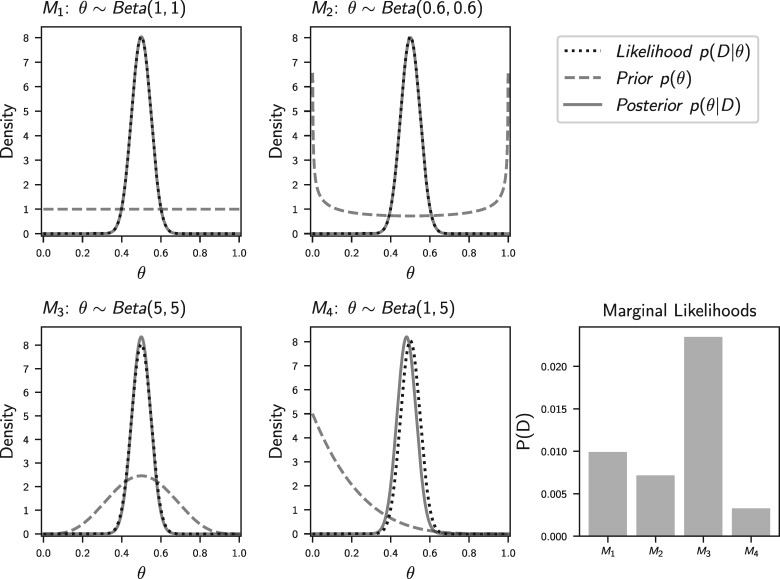
An illustration of the posterior probability densities and marginal likelihoods of the four different prior assumptions we made in our coin-flipping experiment. The data are 50 “heads” out of 100 coin flips, and the parameter, \documentclass[12pt]{minimal}
\usepackage{amsmath}
\usepackage{wasysym}
\usepackage{amsfonts}
\usepackage{amssymb}
\usepackage{amsbsy}
\usepackage{upgreek}
\usepackage{mathrsfs}
\setlength{\oddsidemargin}{-69pt}
\begin{document}
}{}${\theta_{}}$\end{document}, is the probability of the coin landing heads side up. The binomial likelihood density function is proportional to a \documentclass[12pt]{minimal}
\usepackage{amsmath}
\usepackage{wasysym}
\usepackage{amsfonts}
\usepackage{amssymb}
\usepackage{amsbsy}
\usepackage{upgreek}
\usepackage{mathrsfs}
\setlength{\oddsidemargin}{-69pt}
\begin{document}
}{}$\textrm{Beta}(51, 51)$\end{document} and is the same across the four different beta priors on \documentclass[12pt]{minimal}
\usepackage{amsmath}
\usepackage{wasysym}
\usepackage{amsfonts}
\usepackage{amssymb}
\usepackage{amsbsy}
\usepackage{upgreek}
\usepackage{mathrsfs}
\setlength{\oddsidemargin}{-69pt}
\begin{document}
}{}${\theta_{}}$\end{document} (\documentclass[12pt]{minimal}
\usepackage{amsmath}
\usepackage{wasysym}
\usepackage{amsfonts}
\usepackage{amssymb}
\usepackage{amsbsy}
\usepackage{upgreek}
\usepackage{mathrsfs}
\setlength{\oddsidemargin}{-69pt}
\begin{document}
}{}$M_1$\end{document}–\documentclass[12pt]{minimal}
\usepackage{amsmath}
\usepackage{wasysym}
\usepackage{amsfonts}
\usepackage{amssymb}
\usepackage{amsbsy}
\usepackage{upgreek}
\usepackage{mathrsfs}
\setlength{\oddsidemargin}{-69pt}
\begin{document}
}{}$M_4$\end{document}). The posterior of each model is a \documentclass[12pt]{minimal}
\usepackage{amsmath}
\usepackage{wasysym}
\usepackage{amsfonts}
\usepackage{amssymb}
\usepackage{amsbsy}
\usepackage{upgreek}
\usepackage{mathrsfs}
\setlength{\oddsidemargin}{-69pt}
\begin{document}
}{}$\textrm{Beta}(\alpha + 50, \beta + 50)$\end{document} distribution. The marginal likelihoods (\documentclass[12pt]{minimal}
\usepackage{amsmath}
\usepackage{wasysym}
\usepackage{amsfonts}
\usepackage{amssymb}
\usepackage{amsbsy}
\usepackage{upgreek}
\usepackage{mathrsfs}
\setlength{\oddsidemargin}{-69pt}
\begin{document}
}{}$P(D)$\end{document}; the average of the likelihood density curve weighted by the prior) of the four models are compared.